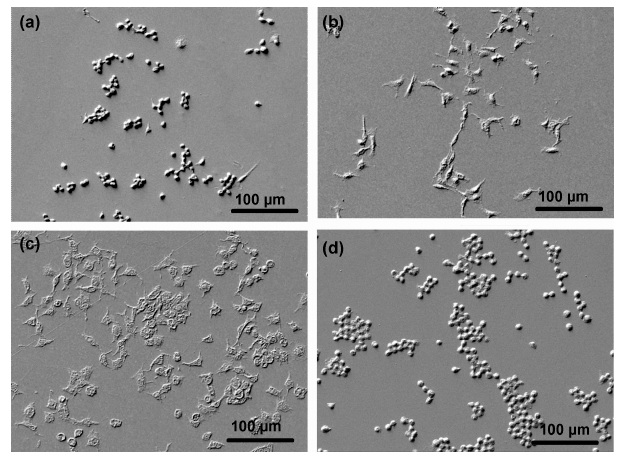
Figure 12. SEM images of cells on PET surfaces treated in various SO 2 + O 2 mixtures after 24 h of incubation: ( a ) 100% SO 2 ; ( b ) 90% SO 2 + 10% O 2 ; ( c ) 60% SO 2 + 40% O 2 ; and ( d ) 10% SO 2 + 90% O 2 .